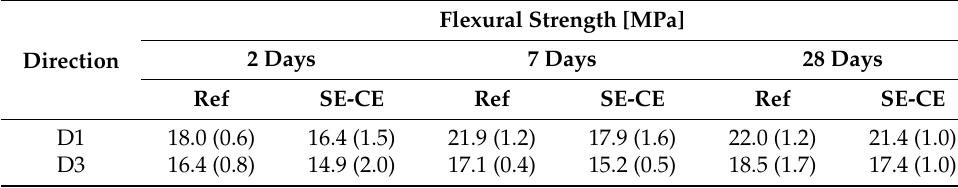
Table 3. Ultimate flexural strength of printed SHCC tested in different directions.